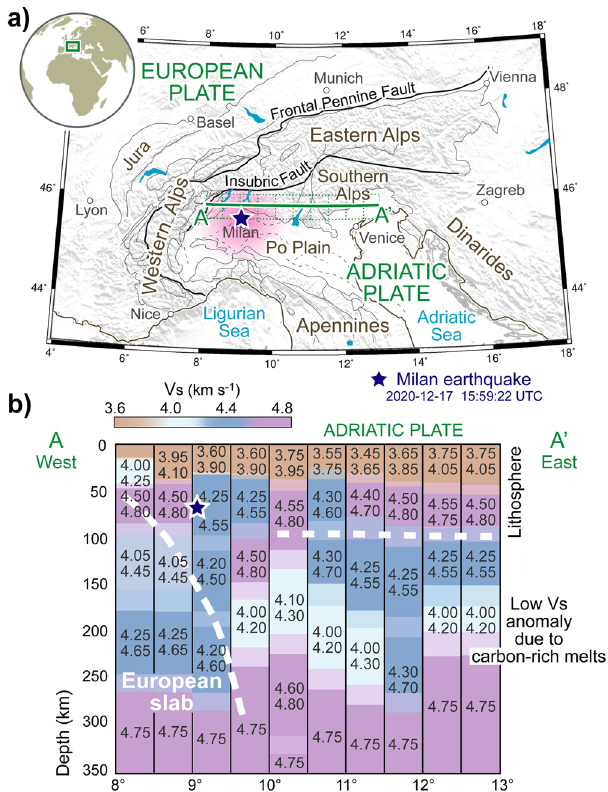
Fig. 1 Location of the 2020-12-17 earthquake beneath Milan. a Tectonic sketch map of the Alpine region (modi fi ed after ref. 48 ). The blue star marks the location of the 4.6±0.3 moment magnitude seismic event recorded in the lithospheric mantle beneath the city of Milan, at 66±20km depth. The earthquake-felt area is shown in magenta. The dashed green lines indicate the cells of the surface-wave absolute tomography model shown in ( b ). b Cross- section of the cellular surface-wave tomography model of the Alpine upper mantle 3,23 . Shaded areas indicate the variability range of layer thickness. The prominent shear-wave low-velocity anomaly beneath the Adriatic plate (light blue colors) is ascribed to carbon-rich melts generated after the breakdown of carbonates and hydrous minerals subducted with the European slab. These melts would be responsible for extensive peridotite carbonation and the formation of a carbon reservoir in the overlying asthenospheric mantle 3 . The white horizontal dashed line indicates the lithosphere-asthenosphere boundary, the east-dipping dashed line indicates the top of the European slab. Image generated using Inkscape 1.0